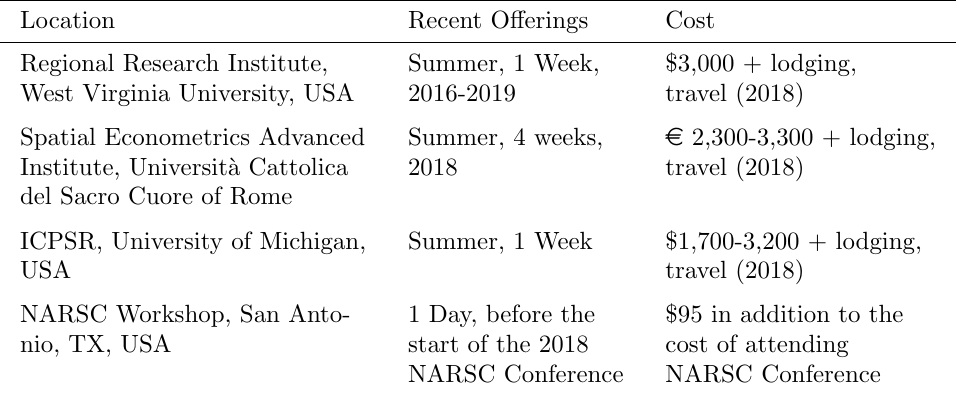
Table 1: Examples of Short Courses related to Spatial Econometrics and Spatial Data